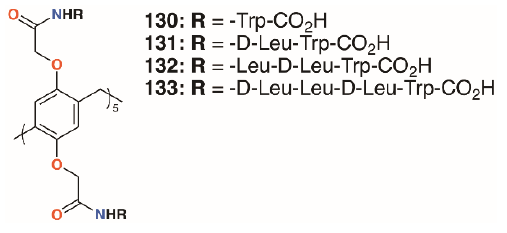
Figure 20. Hou’s pore-forming pillar[5]arenes.